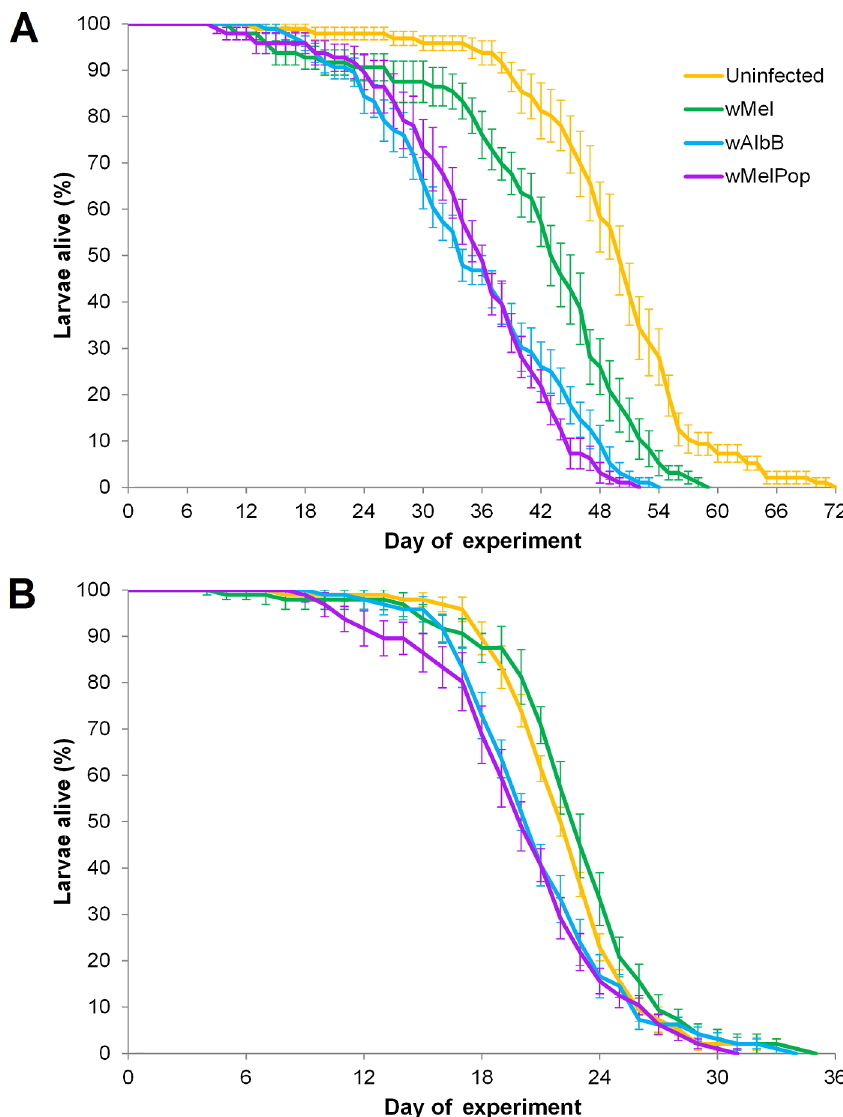
Fig 1. Survival of Ae . aegypti larvae when isolated under starvation conditions. (A) Survival of larvae when there was no manipulation of the wells. (B) Survival of larvae when the water in each well was replaced every four days. Error bars are standard errors. Note that (A) and (B) differ in their x-axis values.